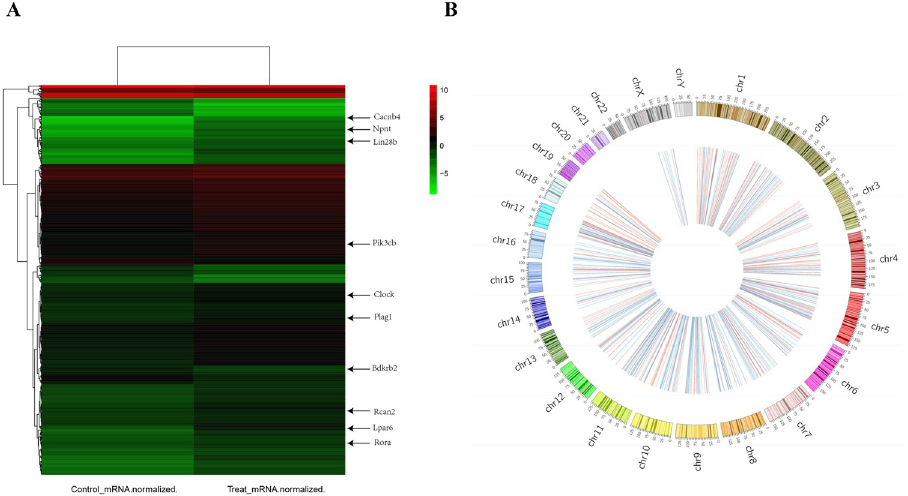
Fig 1. Identification of differentially expressed mRNAs and circRNAs. Heatmap of expression profiles of different mRNAs (A) and circRNAs (B), respectively (fold-change > 1.5 and P < 0.05). Red and green/blue denote high and low relative expression, respectively.